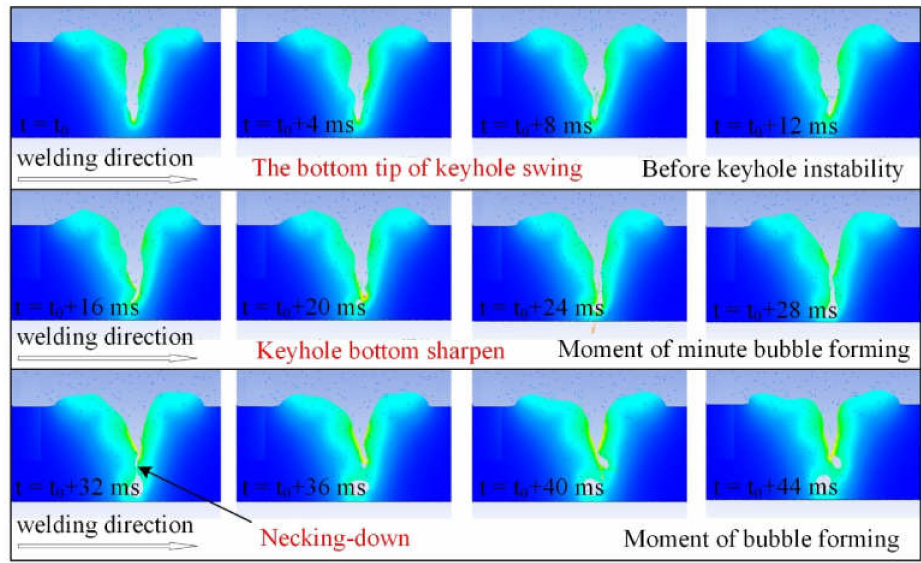
Figure 16. Bubble formation process caused by necking-down of